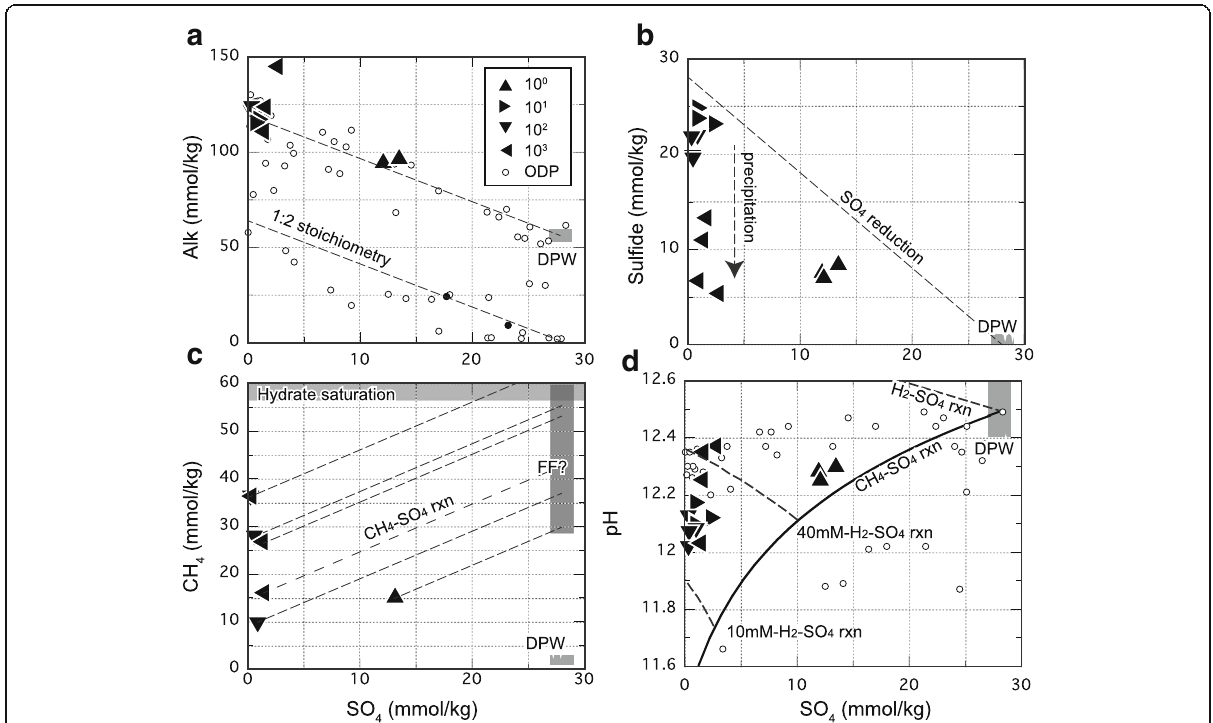
Fig. 4 Relationships between sulfate and alkalinity, sulfide, CH 4 , and pH. Filled triangles represent the CORK fluids from the present study, classified by the number of days after the valve was opened. Filled and open circles represent the CORK fluid observed in 2003 and DPW, respectively, shown for comparison. Light gray zones represent the estimated endmember formation fluid composition of the ODP porewater (DPW) or a solubility of CH 4 hydrate clathrate under the SCS condition (only shown in panel c ). Broken lines in panels ( a ), ( c ), and ( d ) represent ideal changes in the chemical composition based on selected reactions. The dark gray zone in panel ( c ) represents possible CH 4 concentrations of the SCS formation fluid (FF) without post-drilling alteration. The solid curve in panel ( b ) represents sulfate consumption through CH 4 -SO 4 reaction from the porewater-based endmember. Broken curves in panel ( b ) represent sulfate consumption with 10, 40, and > 112 mM of H 2 ,